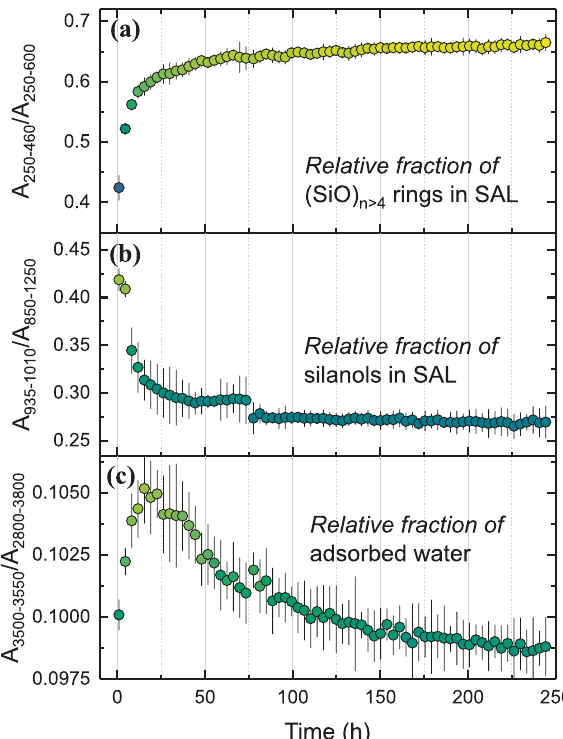
Fig. 4 Structural changes in the SAL over time. Time dependence of the ratios ( a ) A 940 – 1000 / A 750 – 1250 , b A 250 – 460 / A 250 – 600 , and ( c ) A 3560 – 3620 / A 3000 – 3750 taken from the locations encased by the dashed lines (average over 10 pixel) in Fig. 3. Errors bars re fl ect the two- sigma errors.